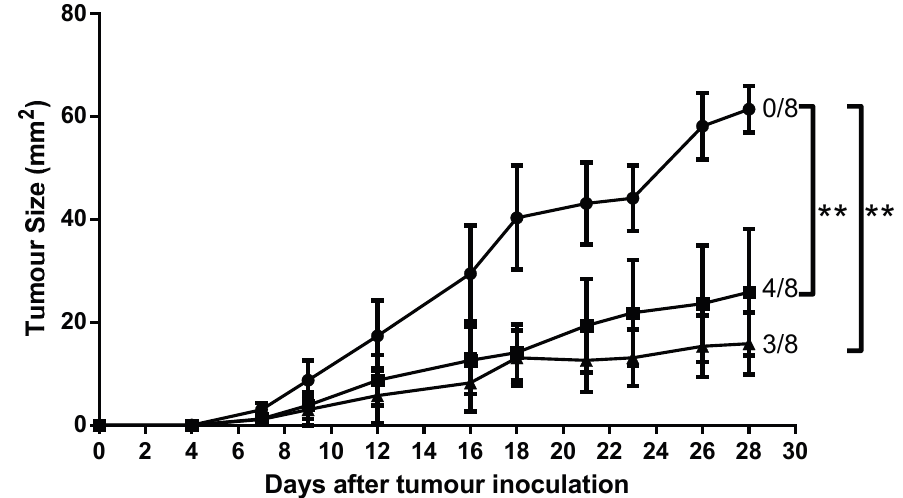
Figure 8. Tumour growth is delayed by immunisation. C57BL/6 mice were immunised on days 0, 10 and 17 with PBS, 25 µg AntpMUC1K b or 25 µg TATMUC1K b then inoculated subcutaneously 7 days after final immunisation with 2 × 10 5 B16-MUC1 melanoma cells into the abdomen. Tumour growth was recorded. Data showing the product of individual perpendicular measurements (mm 2 ) and days post tumour inoculation. Number of tumour-free mice at day 28 is also shown ( n = 8/group, ** p <